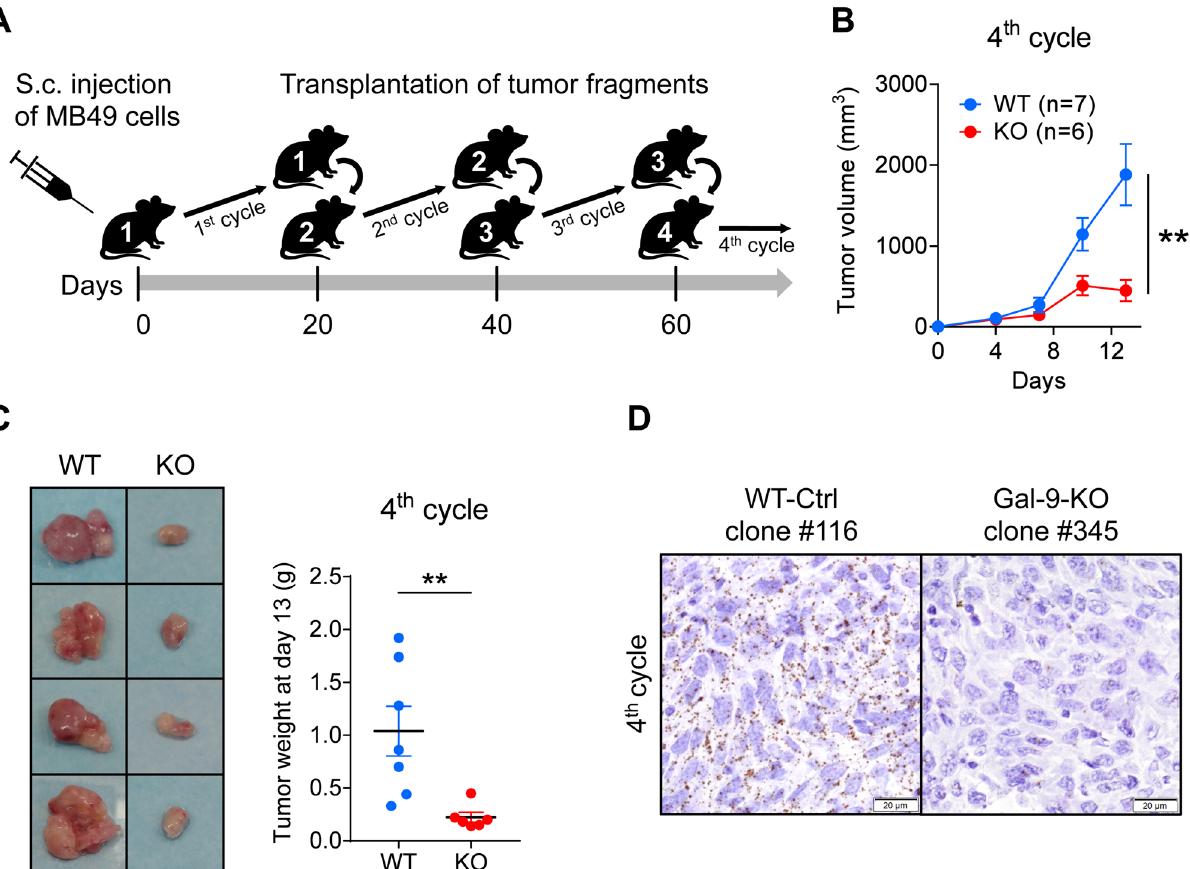
Figure 1. Pilot serial tumor transplantation assay using MB49 cells and isogenic clones in syngeneic mice (C57BL/6 N). ( A ) Cartoon depicting the main steps of the assay. The MB49 parental cell line (n = 3), the WT-Ctrl clone #116 (n = 4), the gal-9-KO clones #345 (n = 2) and #377 (n = 4), were subcutaneously injected into C57BL/6 female mice (opening the 1st cycle of tumor growth involving mice n°1). Twenty days later, tumors were collected and cut into small fragments. For each mouse donor, a small aggregate of tumor fragments (100 mg) was then subcutaneously transplanted into a single recipient mouse (2nd cycle involving mice n°2). This operation was repeated twice (opening the 3rd and 4th cycles of tumor growth involving mice n°3 and mice n°4 respectively). ( B ) Comparison of tumor growth curves for WT and KO tumors during the 4th cycle (mean volumes ± SEM). WT tumors include tumors derived from the parental cells (MB49) and the WT-Ctrl clone #116. Significant differences in tumor volumes were recorded at day 13 (Mann–Whitney test). ( C ) Collection and comparative inspection of WT and gal-9-KO tumors at the completion of the 4th cycle of tumor growth. Left panel: visualization of selected representative tumors (Ctrl clone #116 and KO clone #377). The growth of gal-9-KO tumors was drastically reduced. Only small necrotic tumors were recovered. Right panel: graph showing a comparison of tumor weights for all mice of the 2 groups (7 and 6 mice respectively, Mann–Whitney test). ( D ) RNAscope detection of gal-9 transcripts in WT and KO tumor sections at the completion of the 4th cycle of tumor growth. Several WT and KO tumors were fixed in paraformaldehyde and paraffin-embedded. Then, tumor sections were subjected to in situ hybridization of gal-9 mRNA using the RNAscope method according to the manufacturer instructions (ACD—Biotechne). In tumors derived from parental and WT-Ctrl cells, numerous dots corresponding to gal-9 transcripts were detected in the vast majority of the cells. On the contrary, in gal-9-KO tumors, gal-9 RNA dots were much less abundant and restricted to some isolated cells (likely infiltrating immune cells or endothelial cells from the recipient